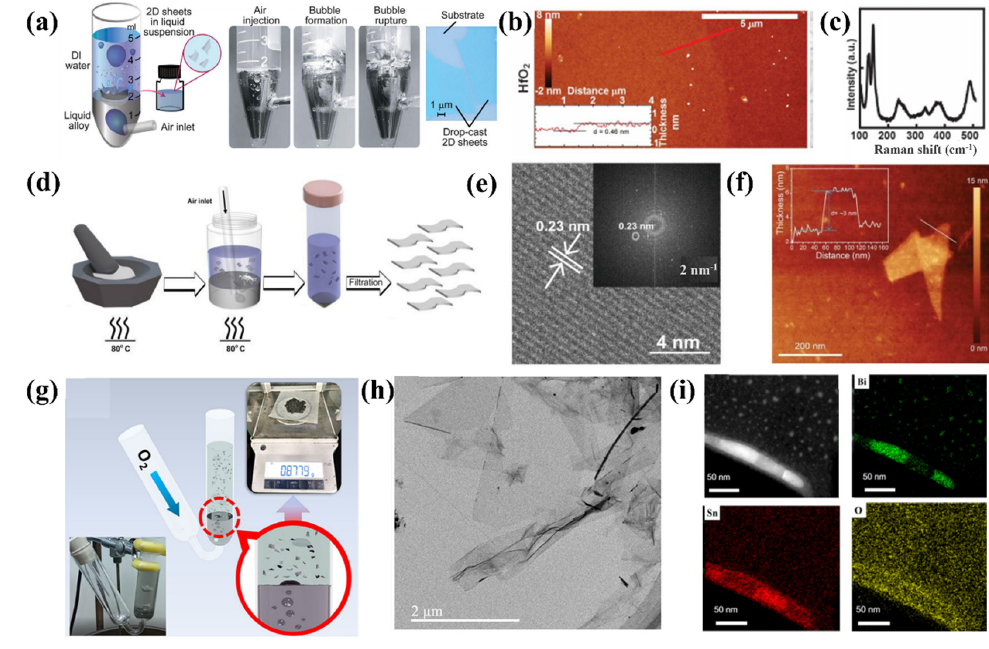
Figure 3. ( a ) Schematic representation of the gas injection method and the optical image of the obtained nanosheets ( b ) AFM and ( c ) Raman spectrum of the HfO 2 nanosheets via gas injection